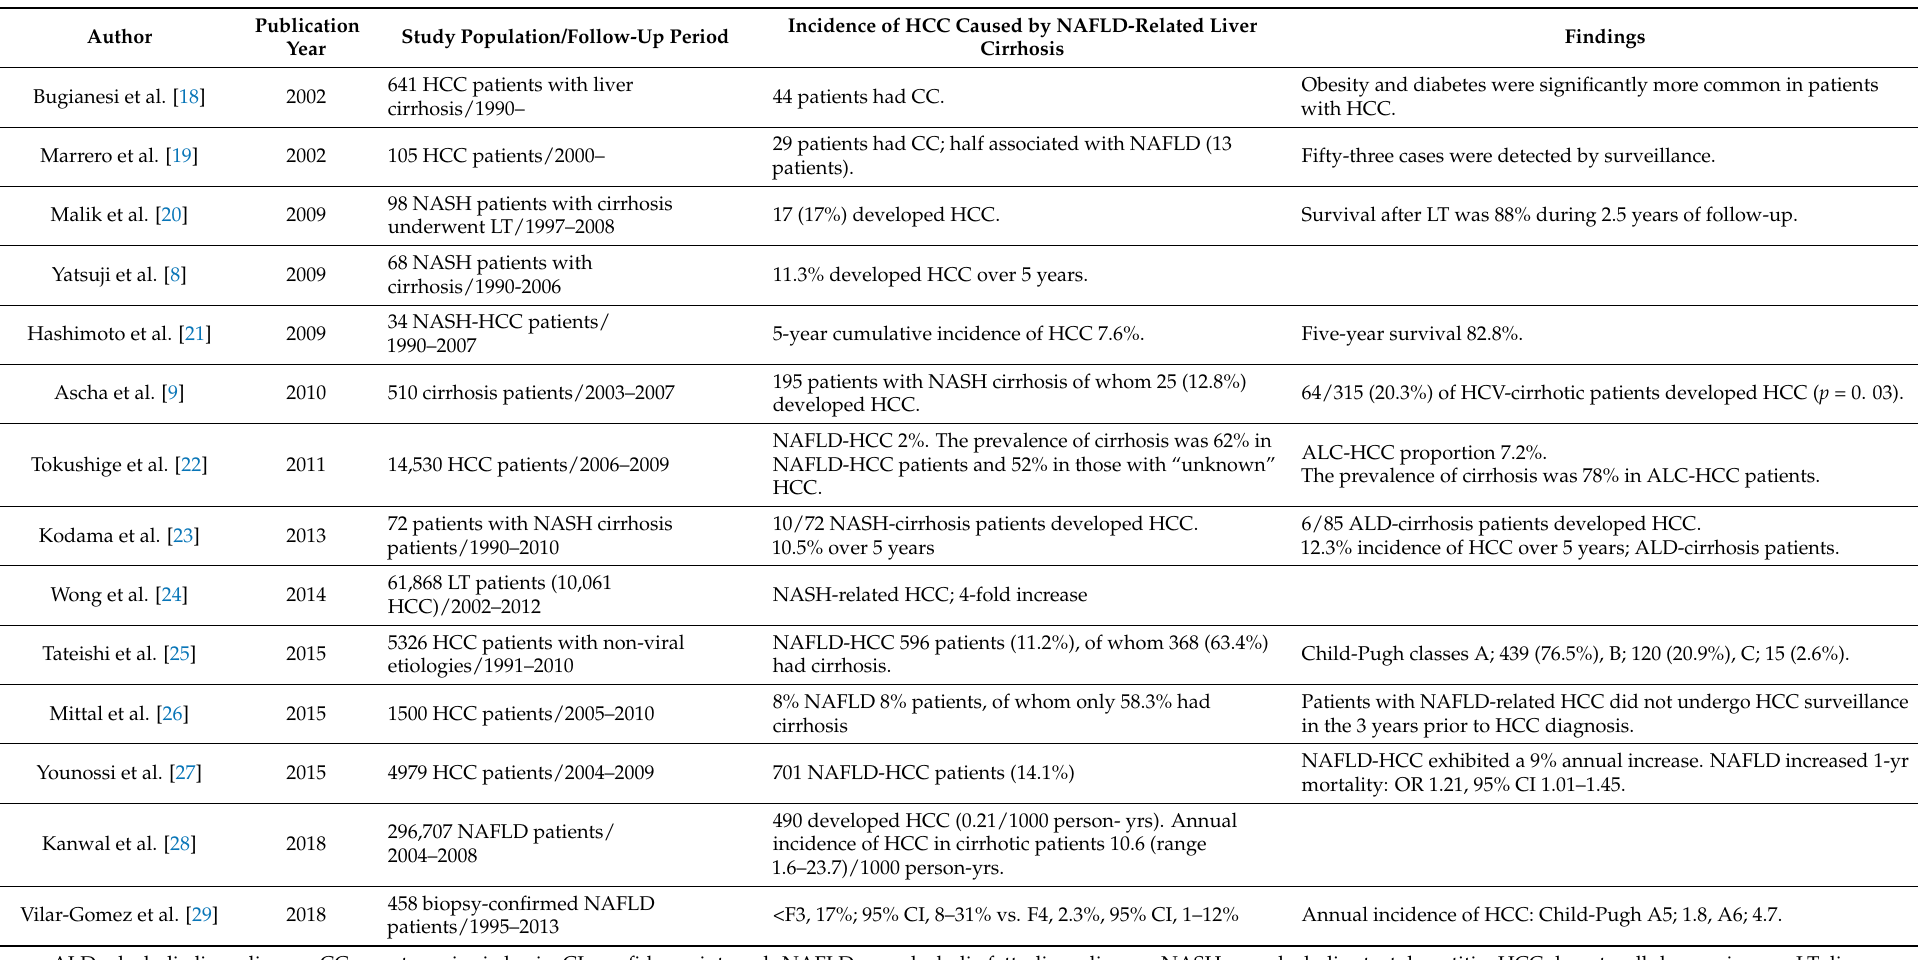
Table 2. Prevalence of NAFLD-HCC in patients with